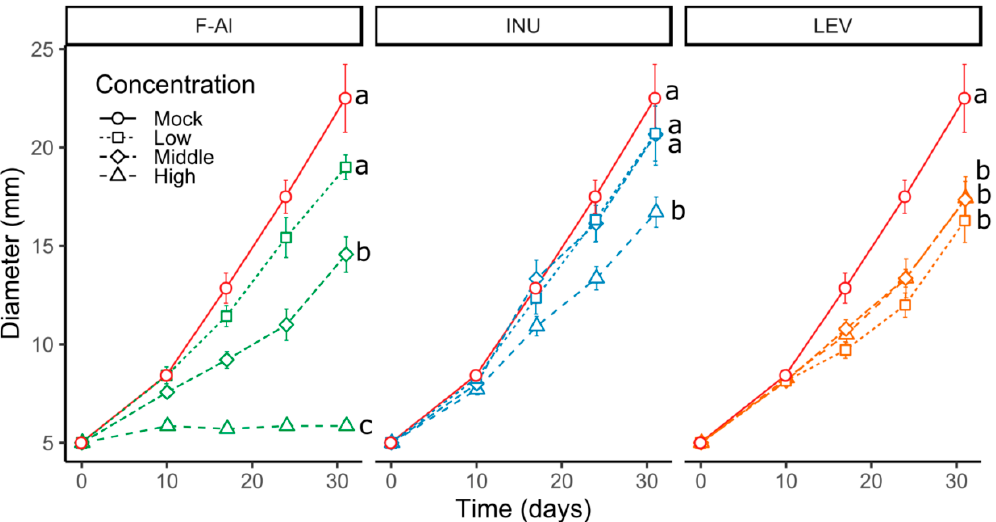
Figure 5. ( A ) Radial mycelial growth of V. inaequalis on peptone dextrose agar plates supplemented with fosetyl ‐ Al (F ‐ Al) and fructans (INU = inulin and LEV = levan) at different concentrations ( n =